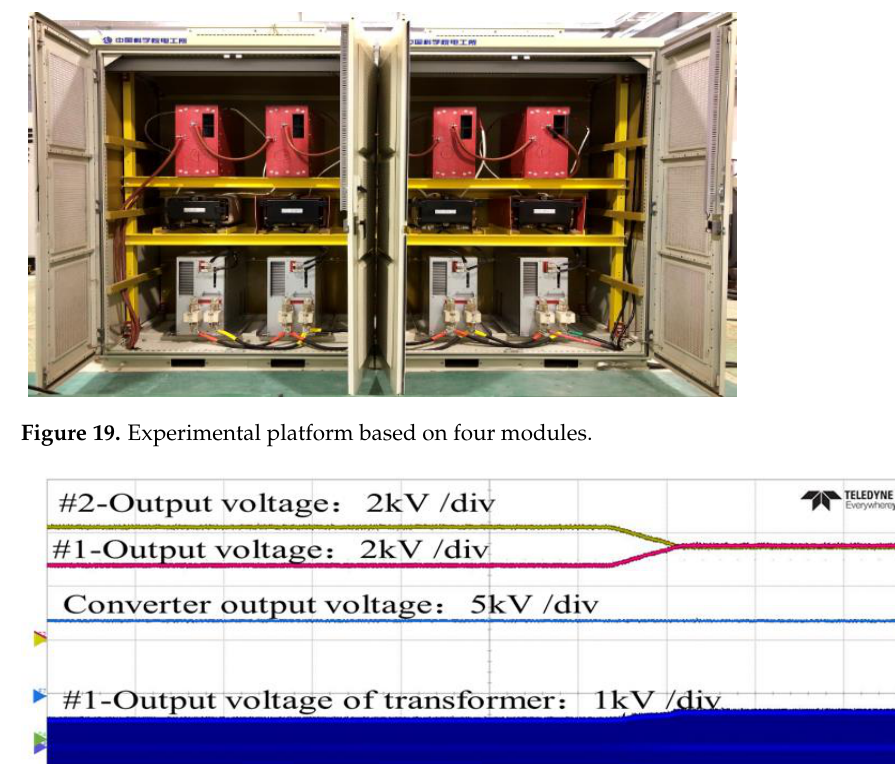
Figure 18. Efficiency curve of the power module. 4.2. Experimental Verification of Multi-Module Cascaded DC/DC Converter